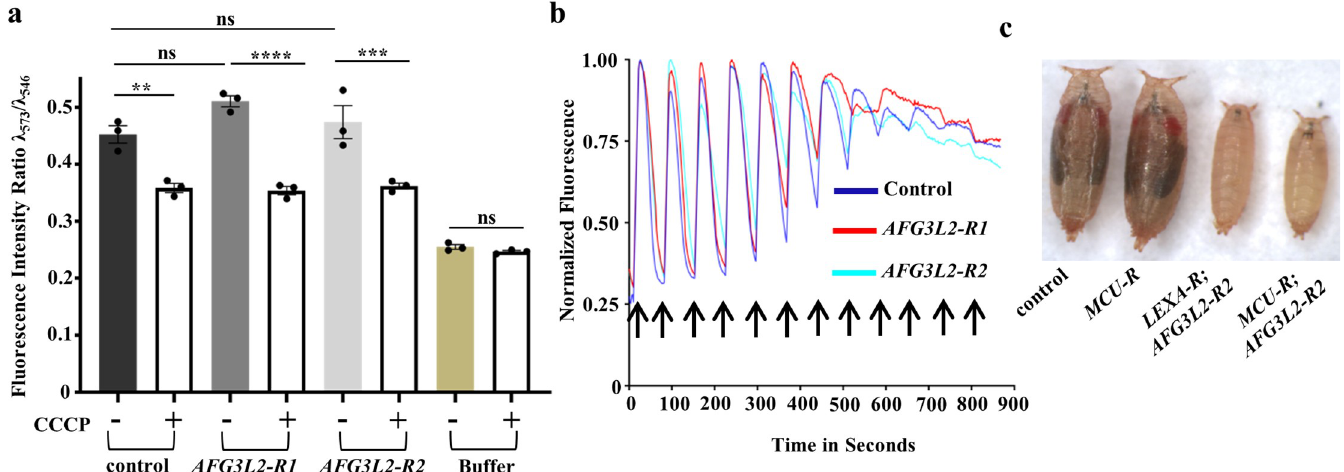
Fig 4. Mitochondrial membrane potential and calcium uptake are unaffected in AFG3L2 -deficient animals. a. Mitochondrial membrane potential was examined using mitochondria from control (UAS- LUCIFERASE RNAi/da-Gal4) and AFG3L2 -deficient (UAS- AFG3L2-R1 RNAi; da-Gal4 and UAS- AFG3L2-R2 RNAi/da-Gal4) pupae. Relative membrane potential was determined by measuring the fluorescence intensity ratio of Tetramethylrhodamine methyl ester perchlorate at 590nm using excitation wavelengths of 546 and 573nm (see materials and methods for details). The CCCP (0.5 mM) was added to samples following the fluorescence scan to normalize for background fluorescence ( �� p < 0.01, ��� p < 0.0005, ���� p < 0.0001 by one way ANOVA Tukey’s test for multiple comparison). b. Calcium uptake capacity of mitochondria isolated from control (UAS- LUCIFERASE RNAi/da-Gal4) and AFG3L2 -deficient (UAS- AFG3L2-R1 RNAi; da-Gal4 and UAS- AFG3L2-R2 RNAi/da-Gal4) pupae was determined using fluorescent dye Oregon green BAPTA 6F. Arrows represent pulses of 50 μ M CaCl 2 given at 1 minute intervals. Experiments were performed using two independent biological replicates and a representative trace is shown. c. Size comparison of control pupae (UAS- LUCIFERASE RNAi/da-Gal4), pupae expressing an RNAi targeting MCU: MCU-R (UAS- MCU RNAi; da-Gal4), AFG3L2 -deficient pupae: LEXA-R; AFG3L2-R2 (UAS- LEXA RNAi; UAS- AFG3L2-R2 RNAi/da-Gal4) and AFG3L2 -deficient pupae expressing an RNAi targeting MCU: MCU-R; AFG3L2-R2 (UAS- MCU RNAi; UAS- AFG3L2-R2 RNAi/ da-Gal4). To account for the possible titration of Gal4 protein in the presence of two UAS transgenes, we compared MCU-R ; AFG3L2-R 2 to AFG3L2-R 2 expressing the RNAi against the exogenous LEXA sequence ( LEXA-R ). Pupae in images were collected 9 days after egg hatching.